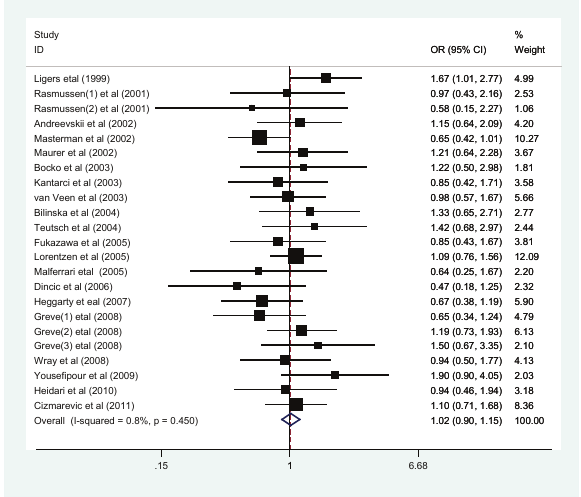
Figure 3: The forest plot of OR for CTLA-4 gene rs221775 A>G single nucleotide polymorphism and multiple sclerosis susceptibility under homozygous genetic model (GG vs AA).